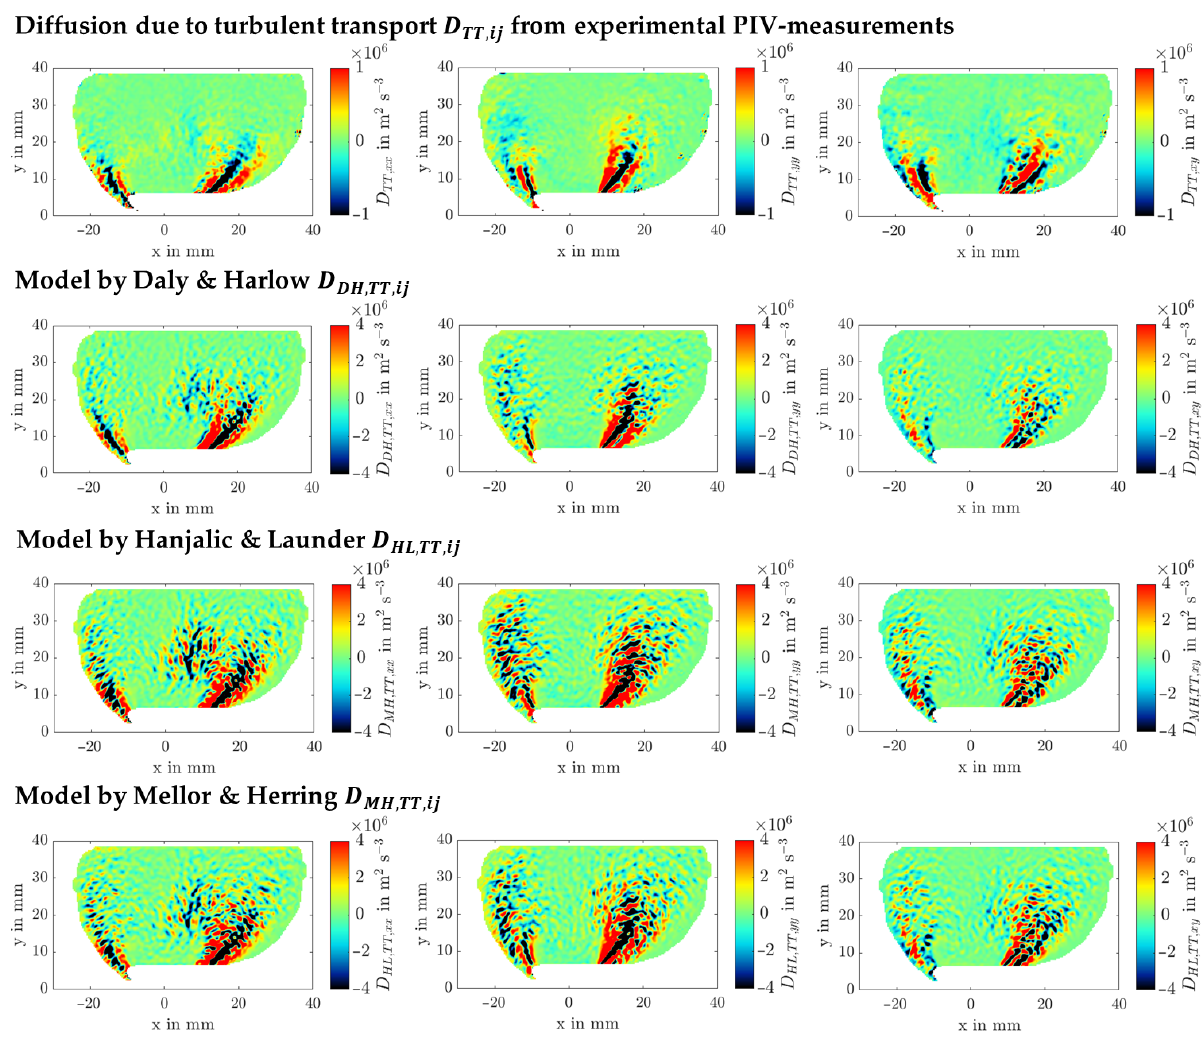
Figure 24. Diffusion of the specific Reynolds stress due to turbulent transport calculated from PIV data and the models of DH, MH and HL, calculated from PIV measurements at 4 mm and 39.6 kg/h, components of xx, yy, and xy from left to right.